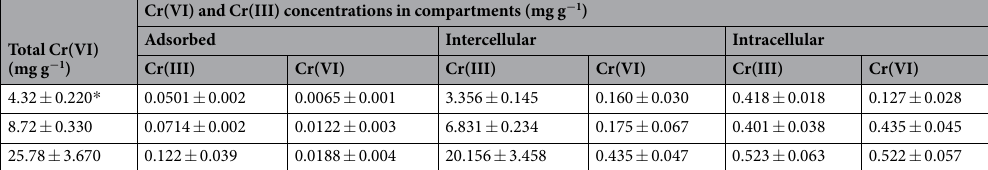
Table 1. Partitions of Cr(VI) and Cr(III) in the activated sludge compartments after 15 days of incubation. Concentrations of Cr(VI) and Cr(III) are expressed on a dry mass basis of activated sludge. * Represent standard deviation